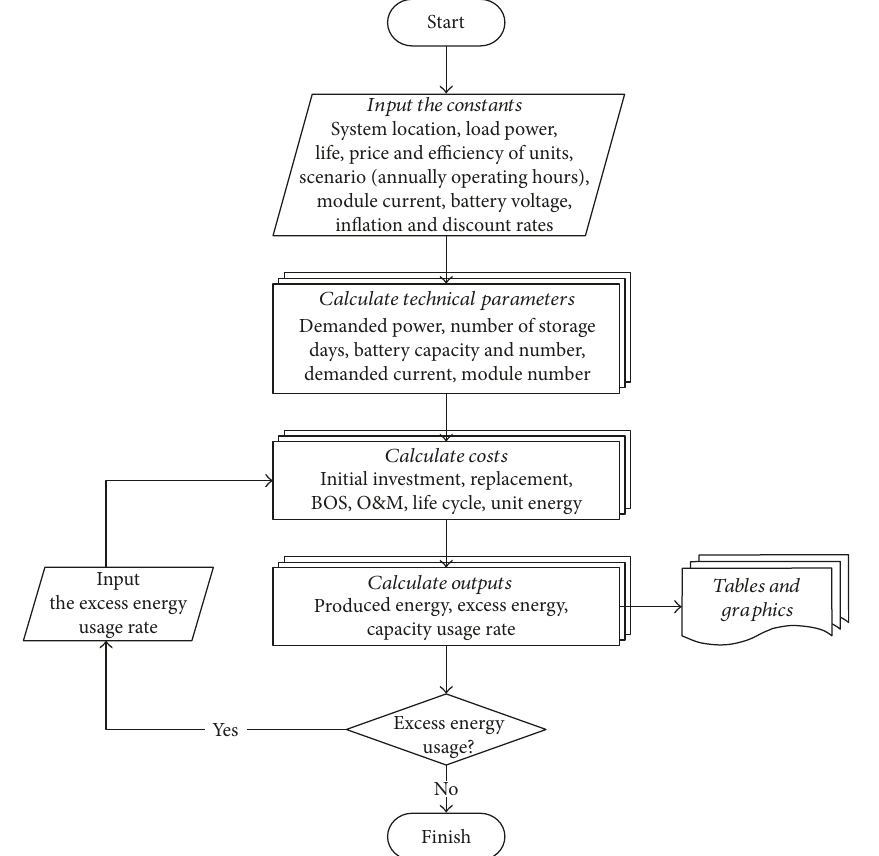
Figure 2: Flowchart of the calculation